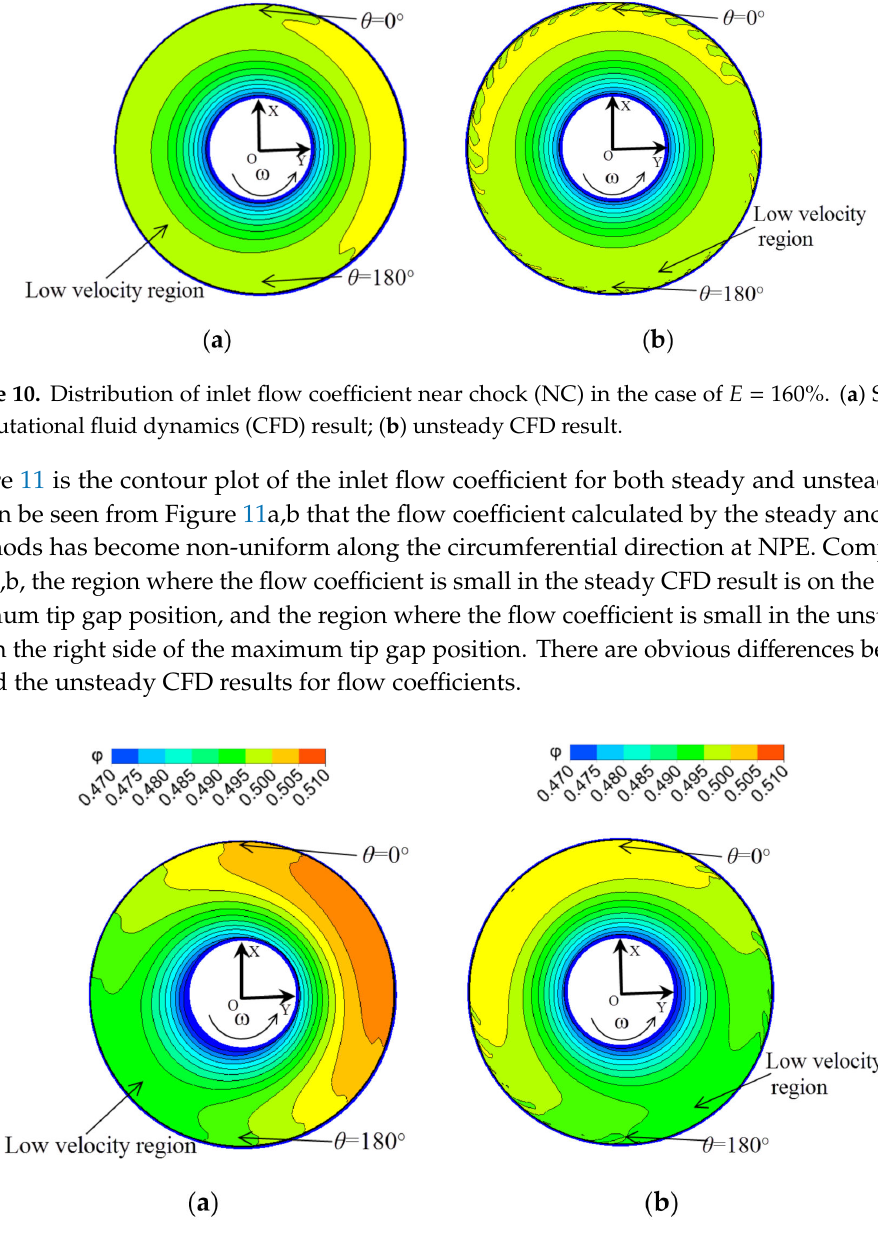
Figure 11. Distribution of inlet flow coe ffi cient NPE in the case of E = 160%. ( a ) Steady CFD result; ( b ) unsteady CFD